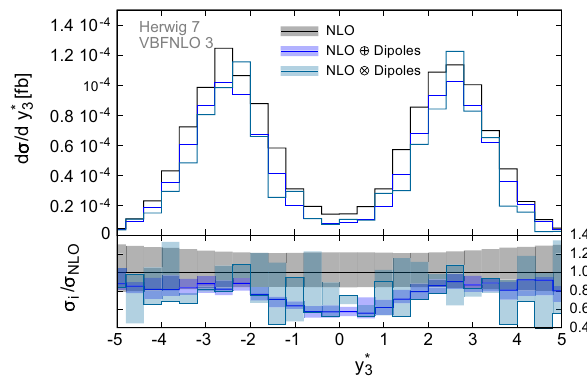
Fig. 9 The relative rapidity of the third jet with respect to the two tagging jets, comparing the fixed-order parton level result ( black ) to the results obtained with the subtractive ( blue ) and multiplicative ( dark cyan ) matching algorithms. The ratio plot shows the ratio with respect to the fixed-order result. The band denotes the change of the differen- tial cross section when varying the factorization, renormalization and hard veto scale jointly around the central value, μ F /μ 0 = μ R /μ 0 = μ /μ ∈ [ 1 ; 2 Q 0 2